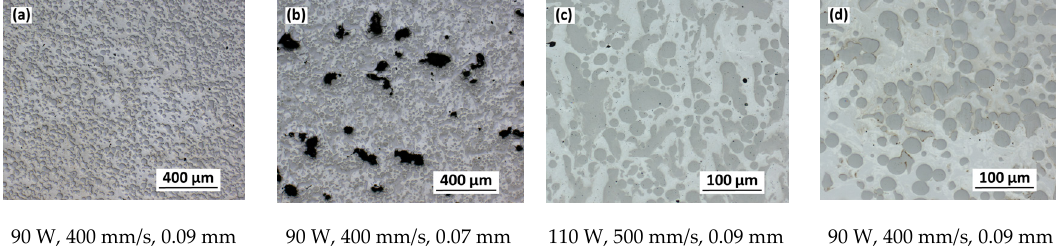
Figure 2. Microstructure observed at sample cross-sections for W, 60 vol% 2nd adaption. Corresponding main parameters are shown below in the following order: laser power, exposure speed, hatching distance. ( a ) Porosity low; ( b ) Porosity high; ( c ) Tungsten content high; ( d ) Tungsten content low.